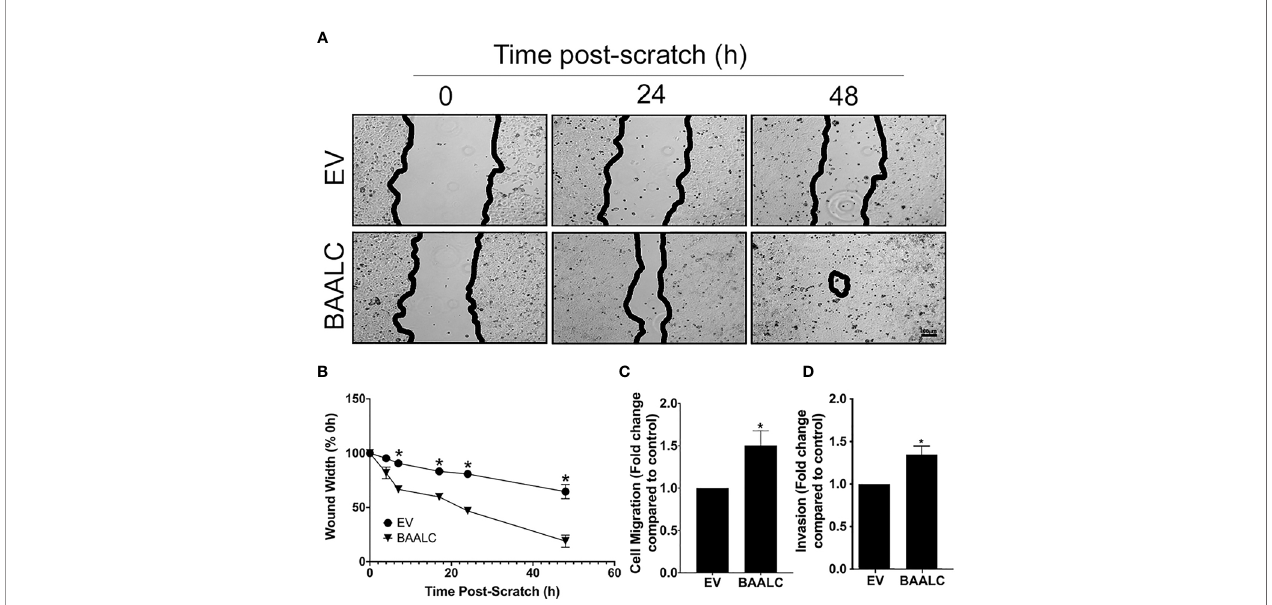
FIGURE 4 | BAALC overexpression increases MCF-7 migration in vitro . MCF-7 cells stably transfected with an empty vector (EV) or BAALC were generated. (A) Con fl uent monolayers of MCF-7-EV and BAALC cells were grown to con fl uence, and a wound was made by scratching with a pipette tip. The wounds were photographed at 4, 7, 17, 24 and 48 h to measure wound closure over time. Photomicrographs are indicative of 6 independent experiments performed in triplicate. (B) Wound widths are expressed as % of 0 h wound width. * denotes statistical signi fi cance (p < 0.05). (C) MCF-7 cells expressing BAALC or EV were placed in the upper chamber of a Transwell and allowed to migrate through the uncoated membrane (8 µm pore) for 4 h. n=3 performed in triplicate. (D) MCF-7 cells expressing BAALC or EV were examined for ability to invade through Matrigel plugs. n=3 performed in triplicate. * denotes statistical signi fi cance p < 0.05.